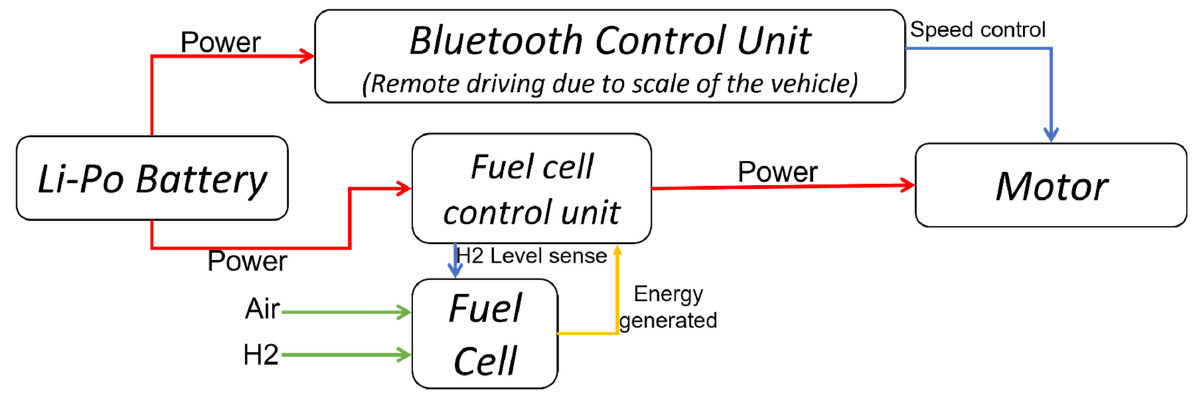
Figure 4. Schematic diagram of the control system of the vehicle.